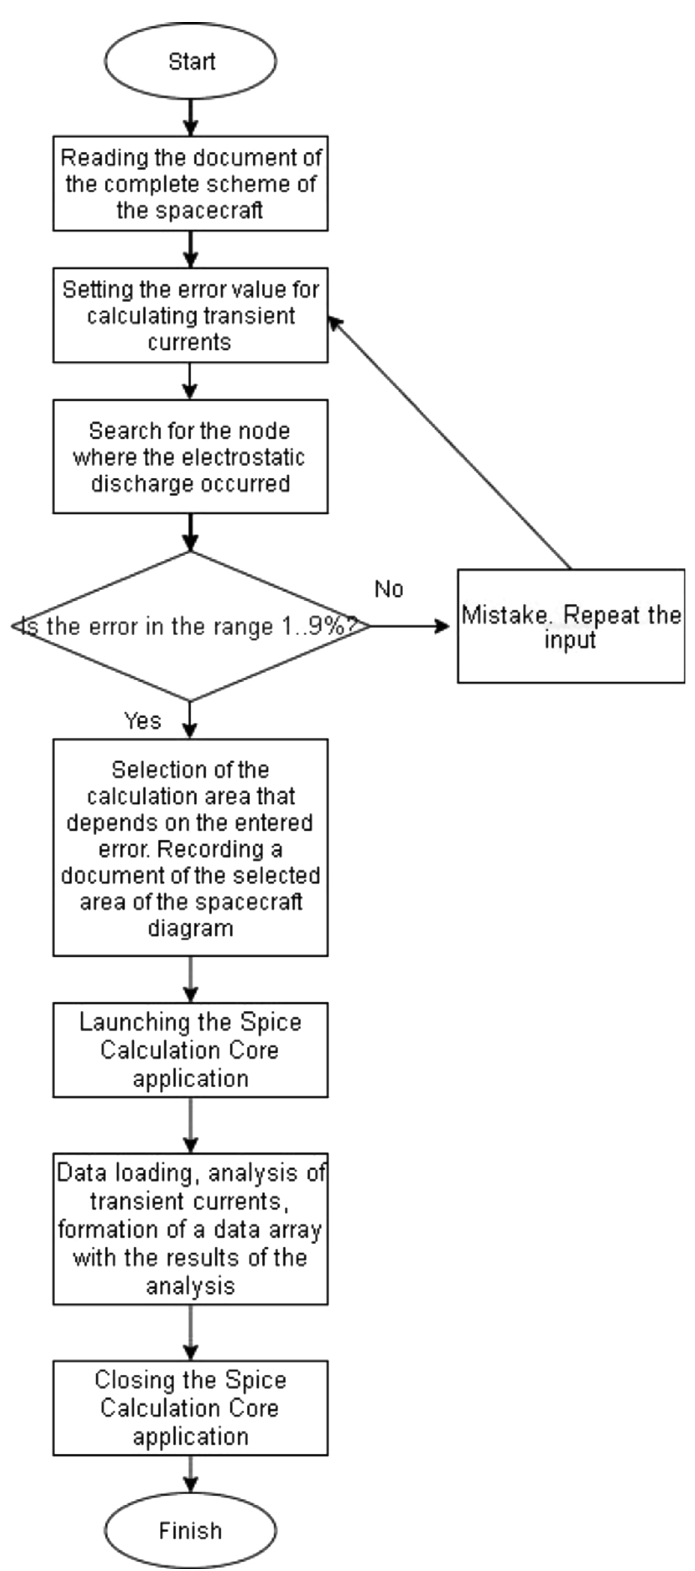
Figure 5. Block diagram of the algorithm for selecting